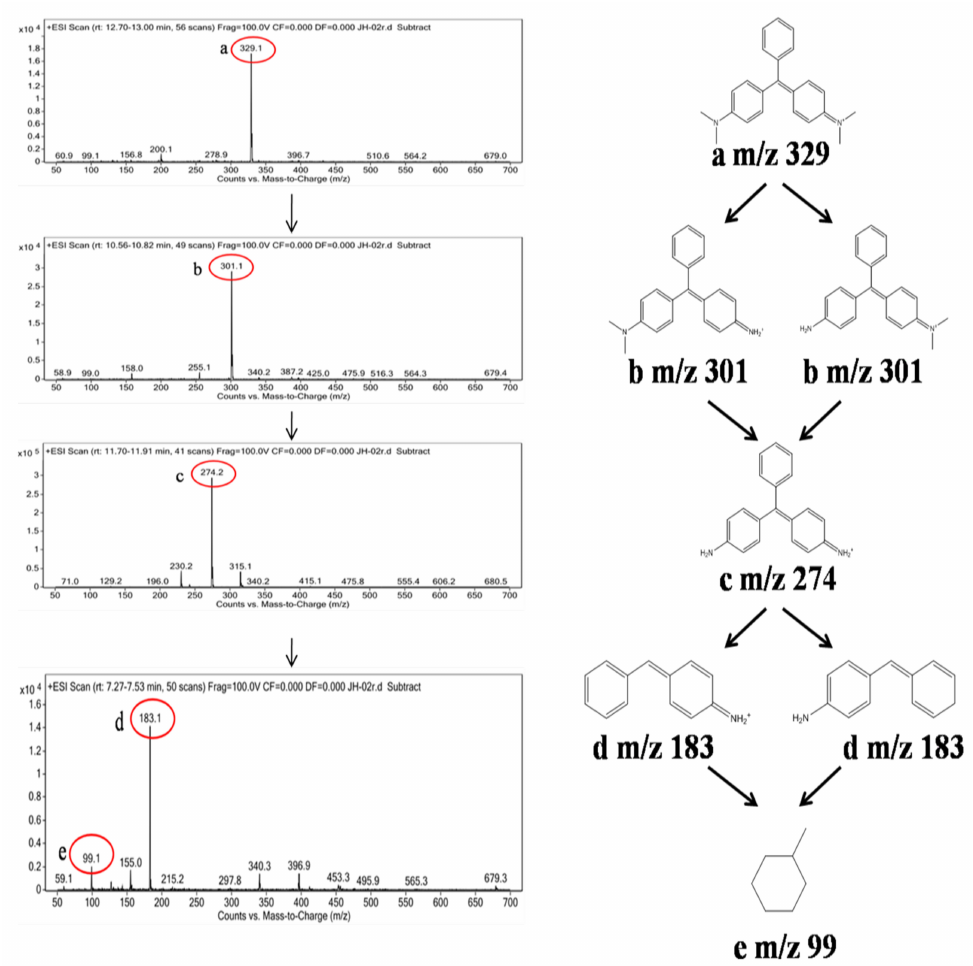
Figure 11. LC–MS analysis of the degradation pathway of MG by